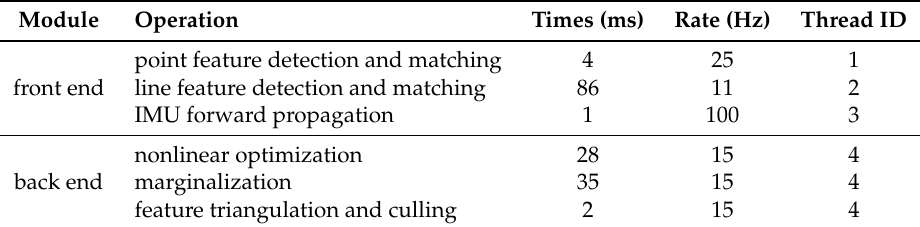
Table 5. Mean execution time of PL-VIO run with the V1_02_medium